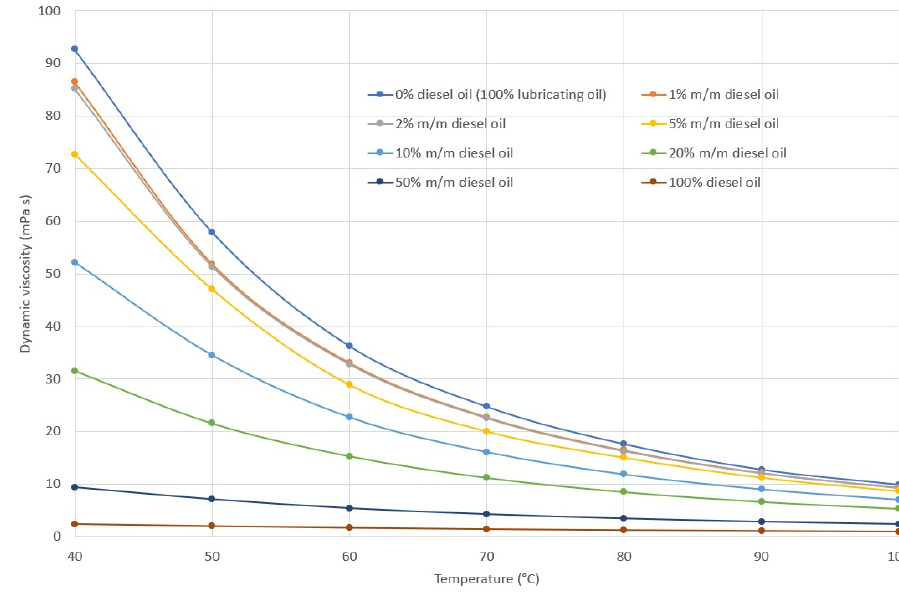
Figure 16. Measured values of dynamic viscosity of SAE 30 class oil in the temperature range of 40–100 °C at different levels of lubricating oil dilution with diesel fuel.